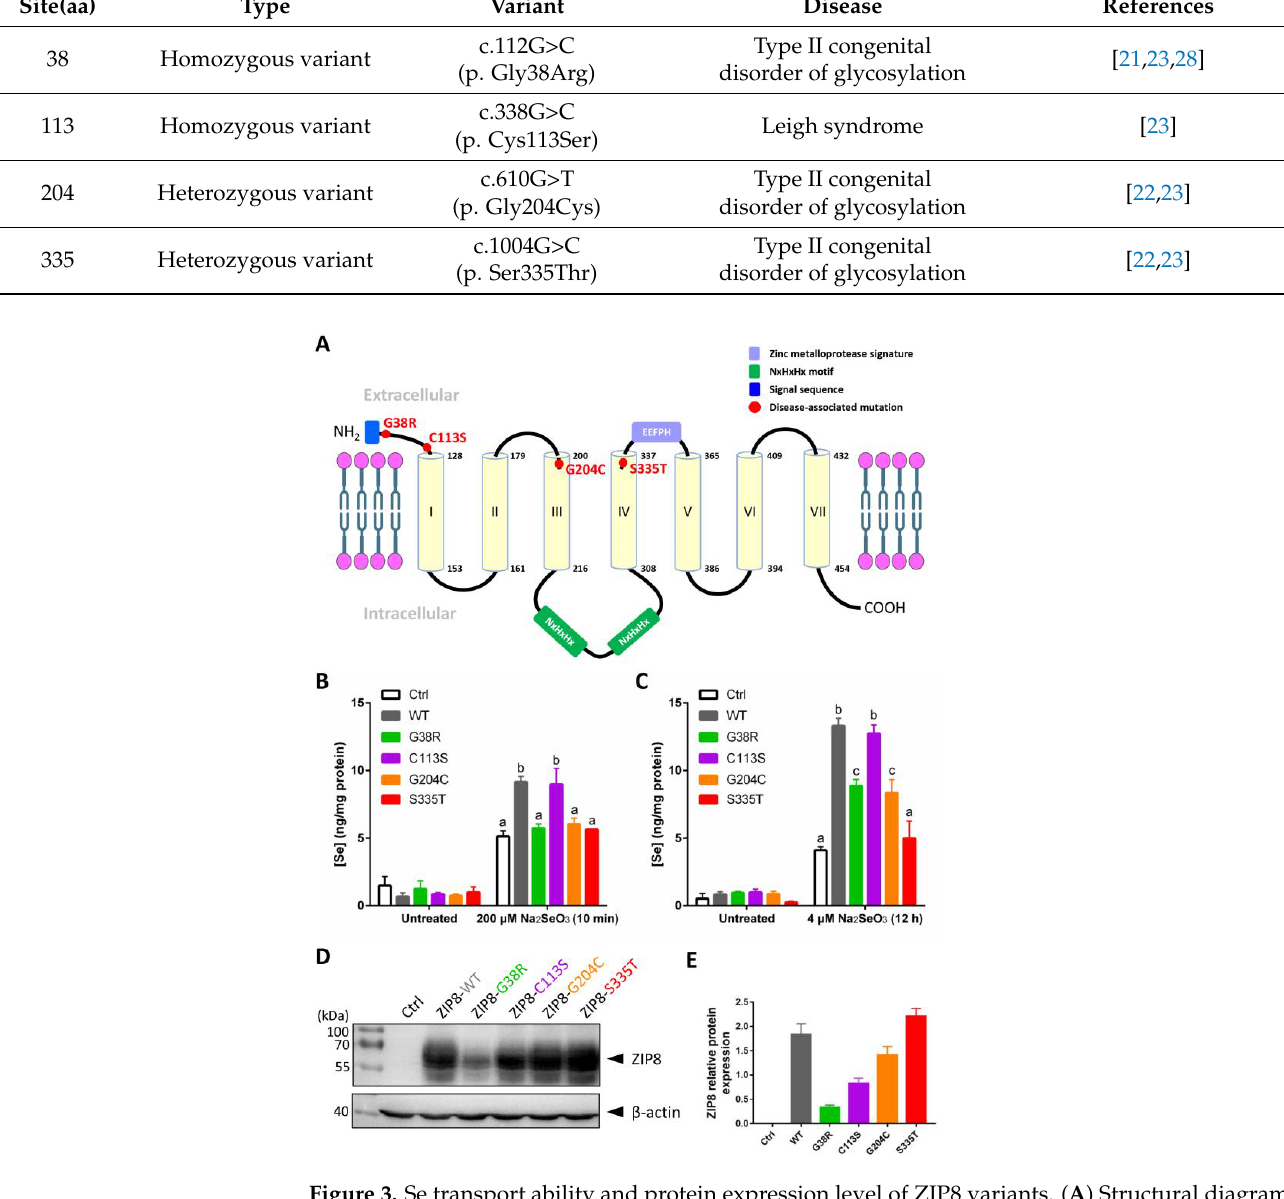
Figure 3. Se transport ability and protein expression level of ZIP8 variants. ( A ) Structural diagram of ZIP8 protein based on in silico predictions. It is predicted that the ZIP8 protein has seven transmembrane domains (TMD, yellow cylinder). The sites of four mutations (G38R, C113S, G204C, and S335T) in ZIP8 were labeled in red color. The N-terminus of ZIP8 has a signal sequence